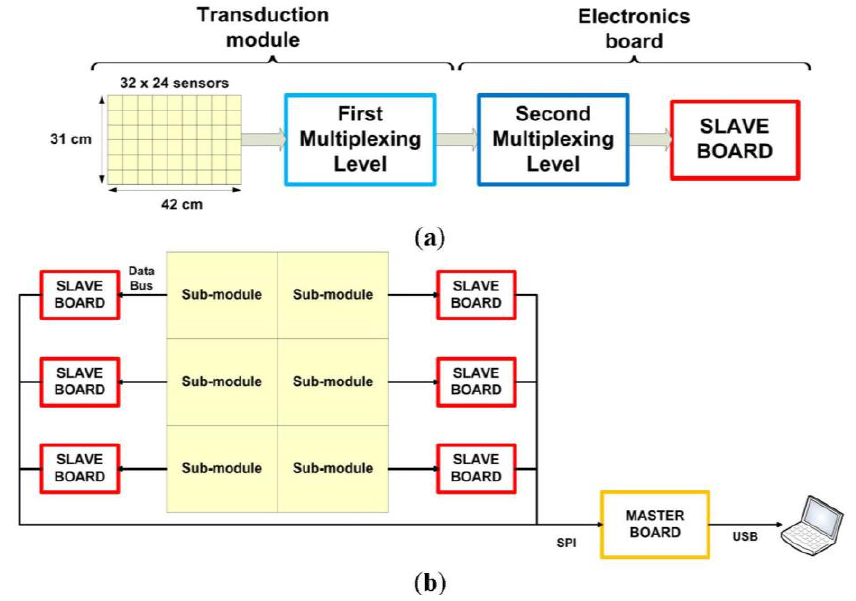
Figure 1. ( a ) Overview of the sub-module’s architecture; ( b ) overview of the overall architecture of the sensorized